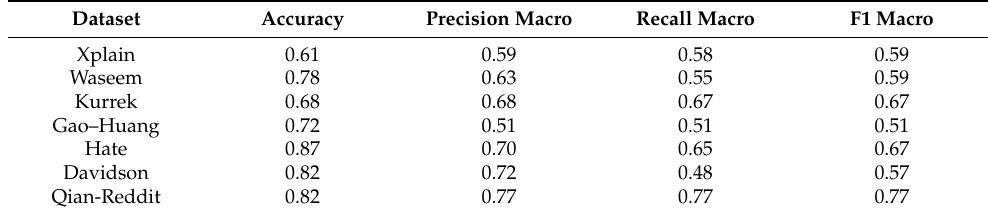
Table A1. Scores obtained on the benchmark Datasets using the K nearest neighbors algorithm. Dataset